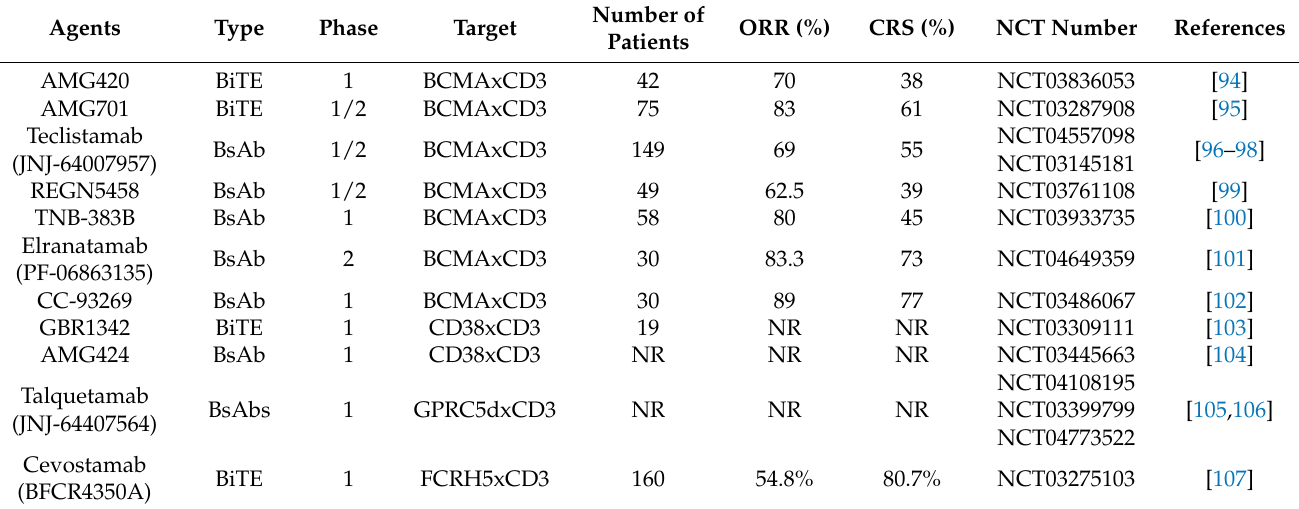
ORR = overall response rate and CRS = cytokine release